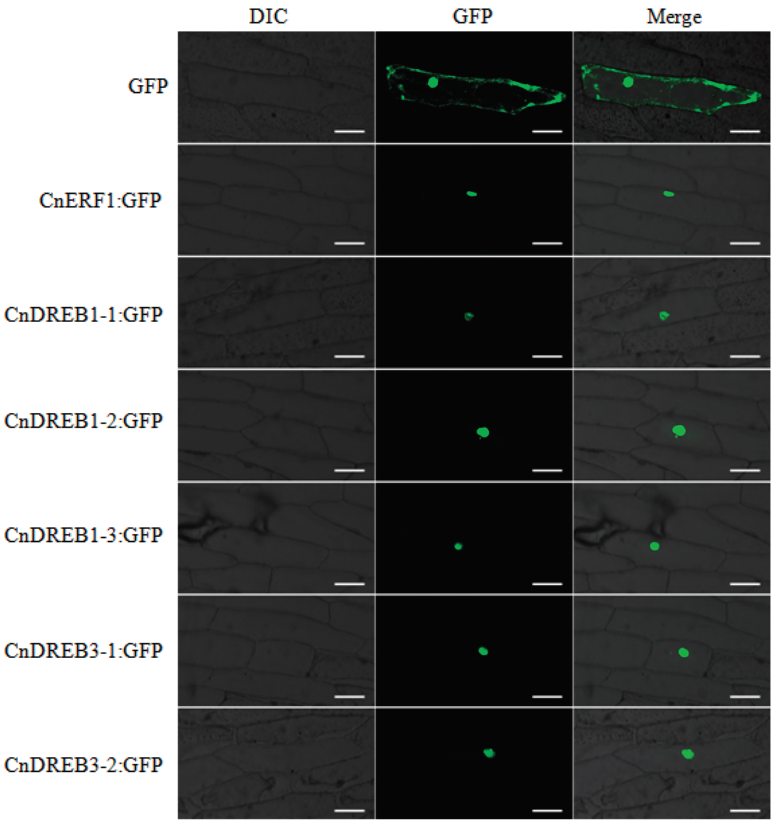
Figure 2. Localization of transiently expressed CnAP2/ERF TF products in onion epidermal cells. The upper row shows the control 35S::GFP signal, and each of the lower rows the signal from one of the 35S::CnAP2/ERF-GFP transgenes. The left panel shows bright field images, the middle one green fluorescence signals detected at 488 nm and the right one the merged Green Fluorescent Protein (GFP) and bright field images. Bar: 50 μ m.